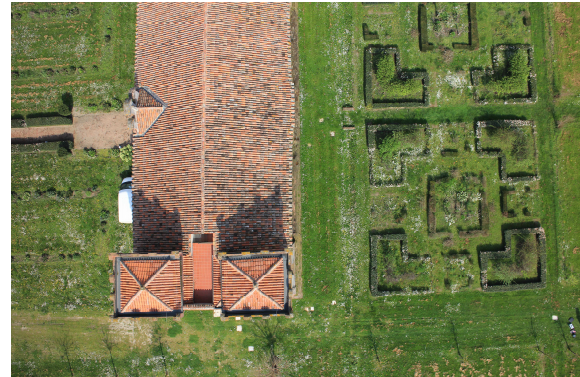
Figure 6. Example of RPAS digital images.